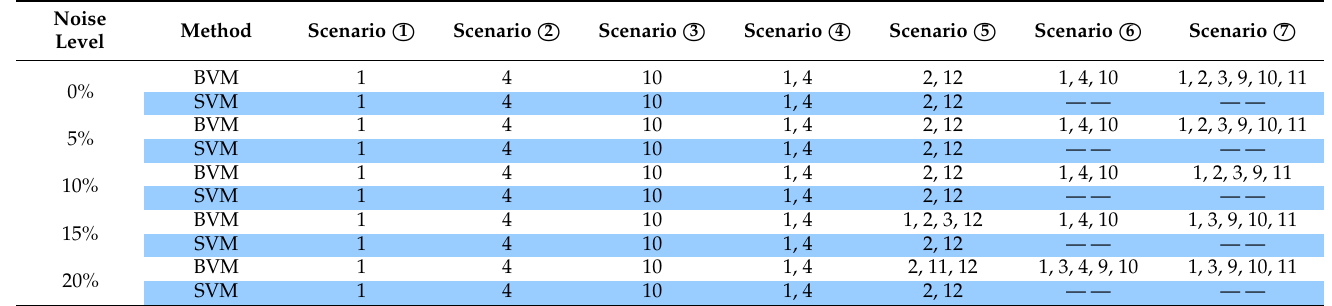
Table 3. Results of identified damaged cables by a set of DIXVs for each damage scenario using the BVM method and the SVM method